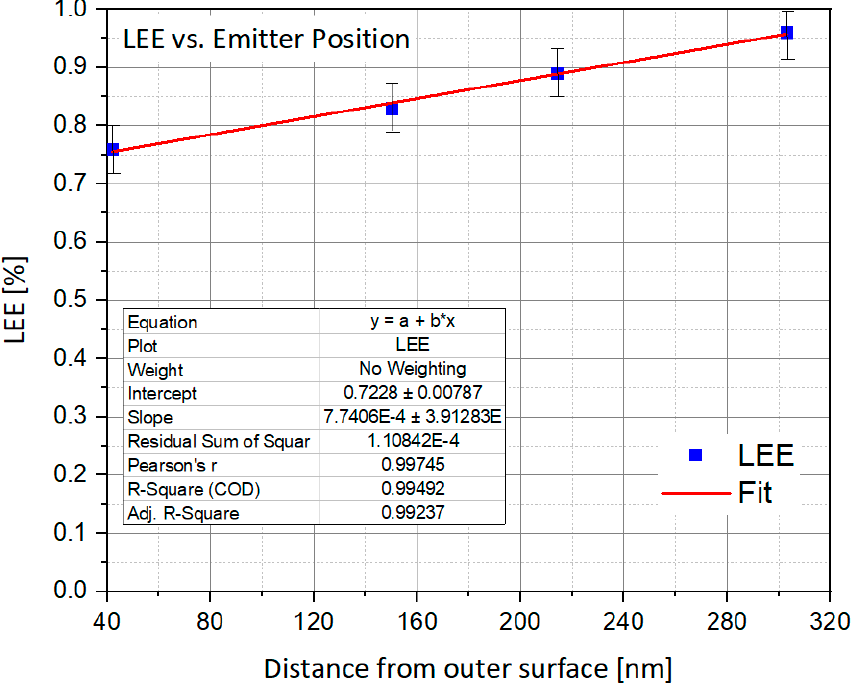
Figure 6. Light Extraction Efficiency vs. Emitter Position.